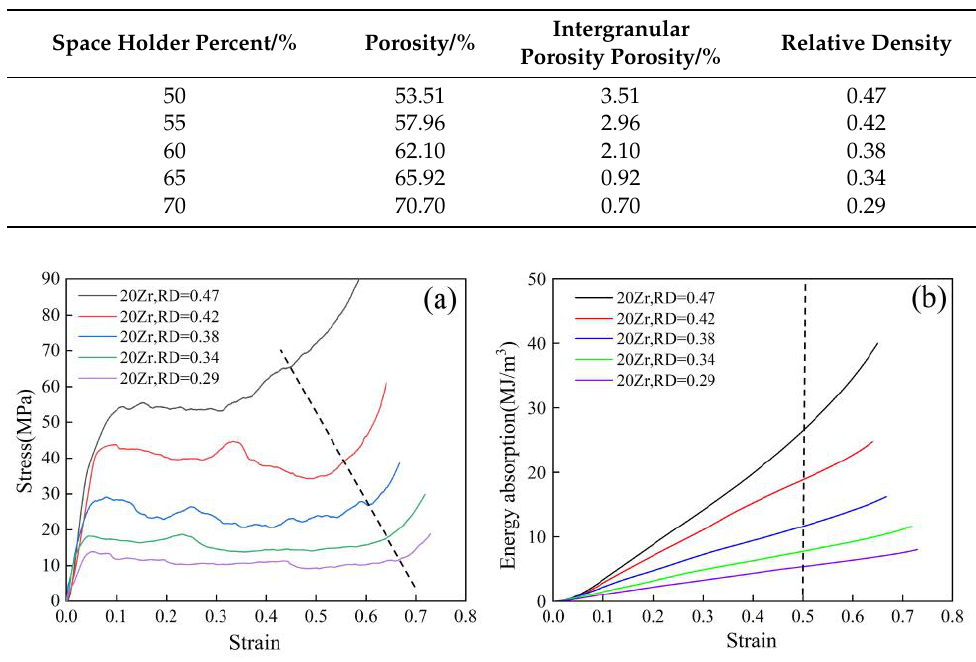
Table 3. The porosity, intergranular porosity and relative density of the composites sintering at different space holder percentages.